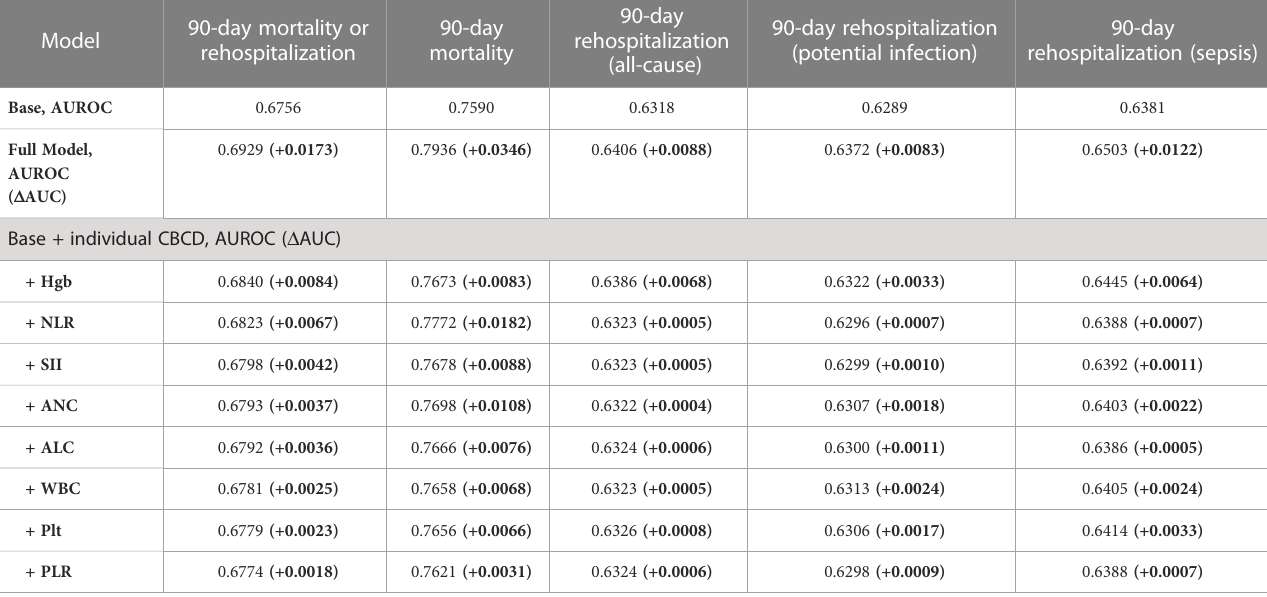
TABLE 3 Discrimination using area under the receiver operator characteristics (AUROC) curves to determine the added value of CBCD parameters to clinical charactersitics in predicting 90-day outcome.